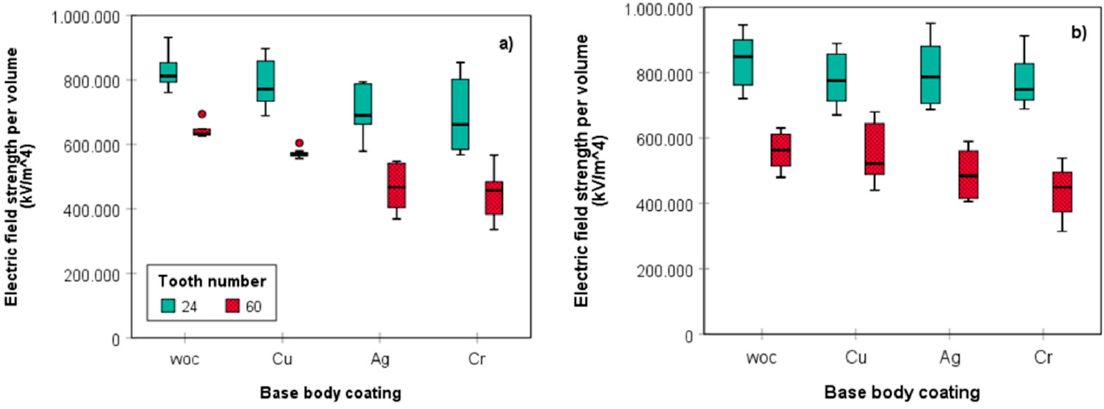
Figure 9. Electric field strength of wood dust produced by circular sawing for ( a ) T10 and ( b ) T20; woc = uncoated, n = 8.